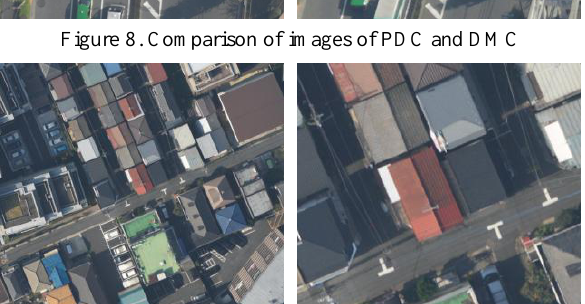
Figure 8. Comparison of images of PDC and DMC